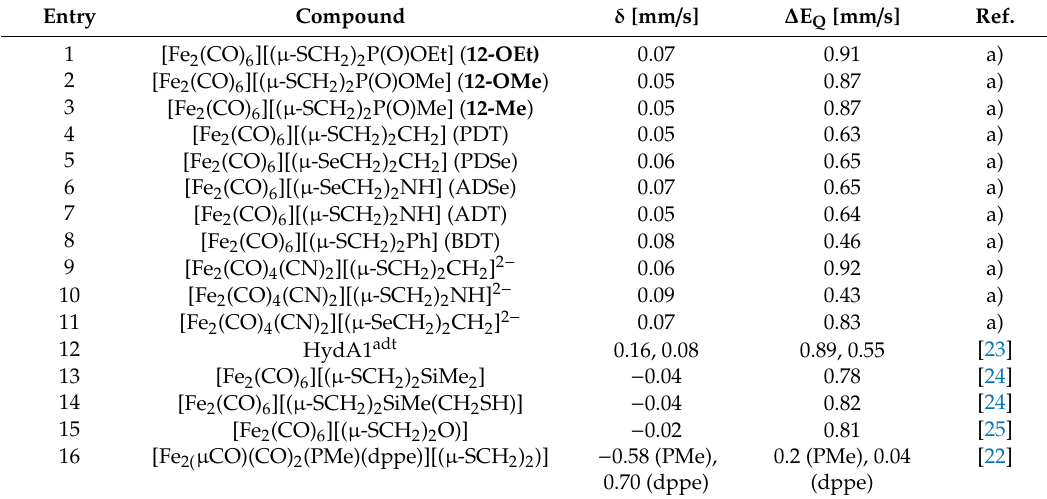
Table 2. Mössbauer parameter of compounds 12-R compared to di ff erent known model complexes.